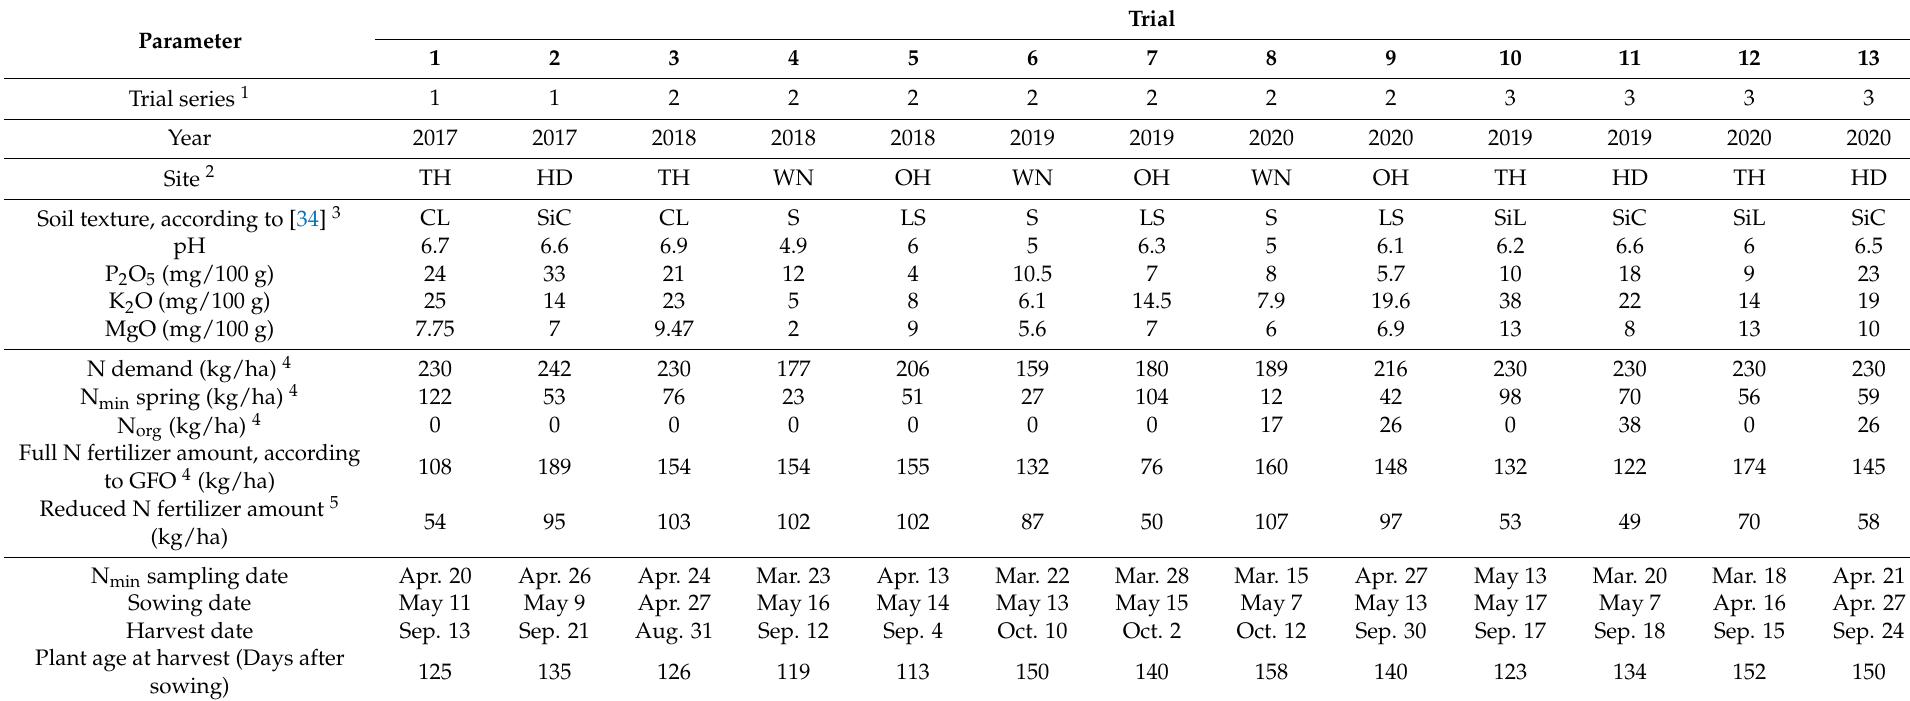
Table 3. Soil characteristics, N fertilization data and crop management dates of the 13 field